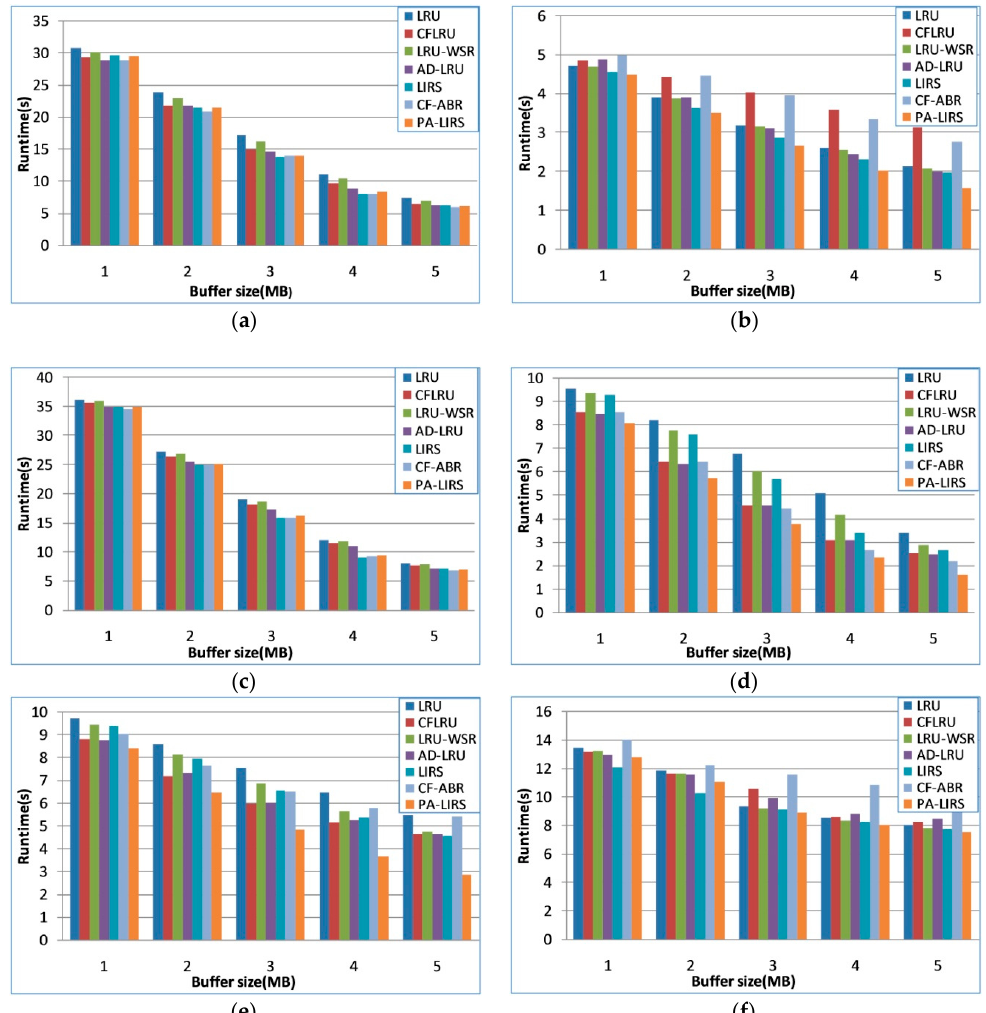
Figure 9. The overall runtimes of the different replacement algorithms under 6 traces. ( a ) T1 trace, ( b ) T2 trace, ( c ) T3 trace, ( d ) T4 trace, ( e ) T5 trace and ( f ) OLTP trace.